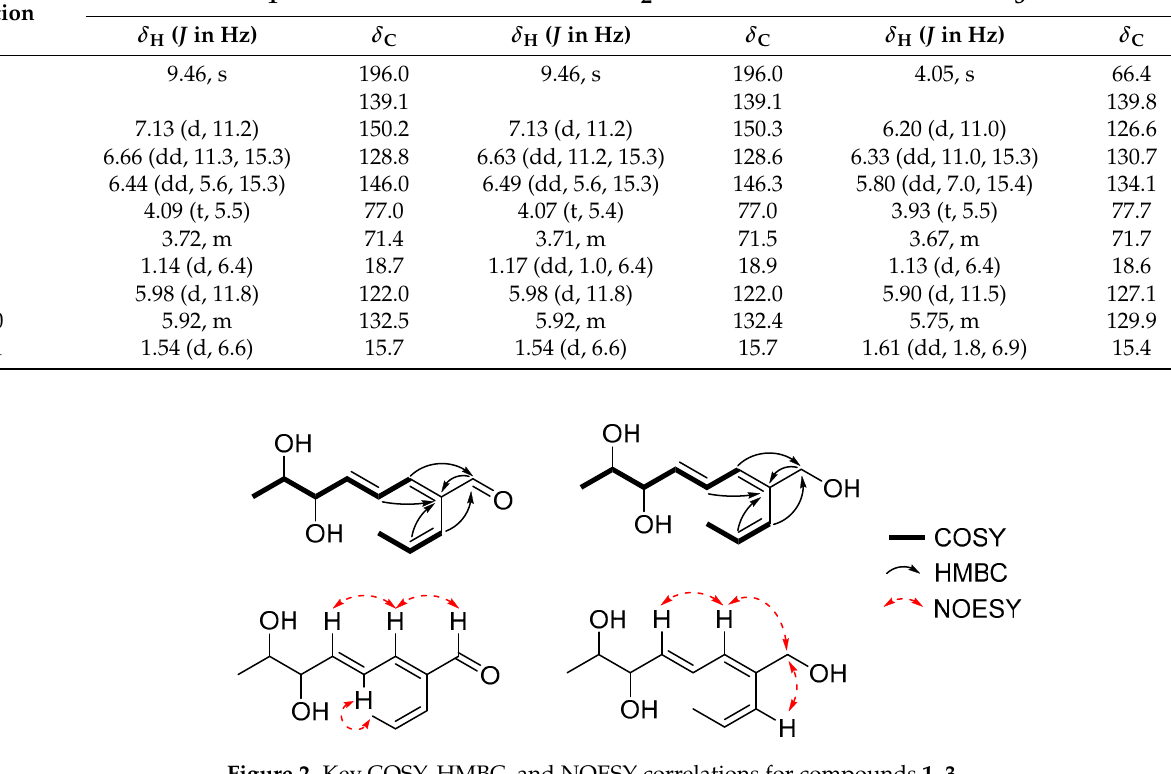
Figure 2. Key COSY, HMBC, and NOESY correlations for compounds 1 − 3 . Compound 3 was obtained as a colorless oil with a molecular formula of C 11 H 18 O 3